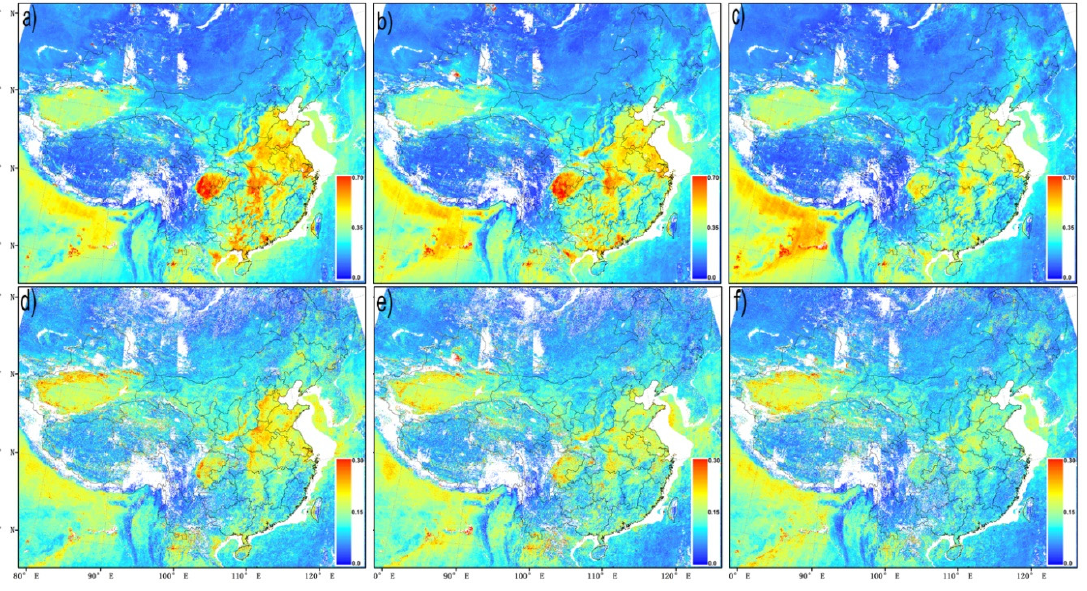
Figure Figure 7. ( a – c ) MISR AOD, and ( d – f ) nonsphercial AOD in 2003–2007, 2008–2012, and 2013–2018, respectively.